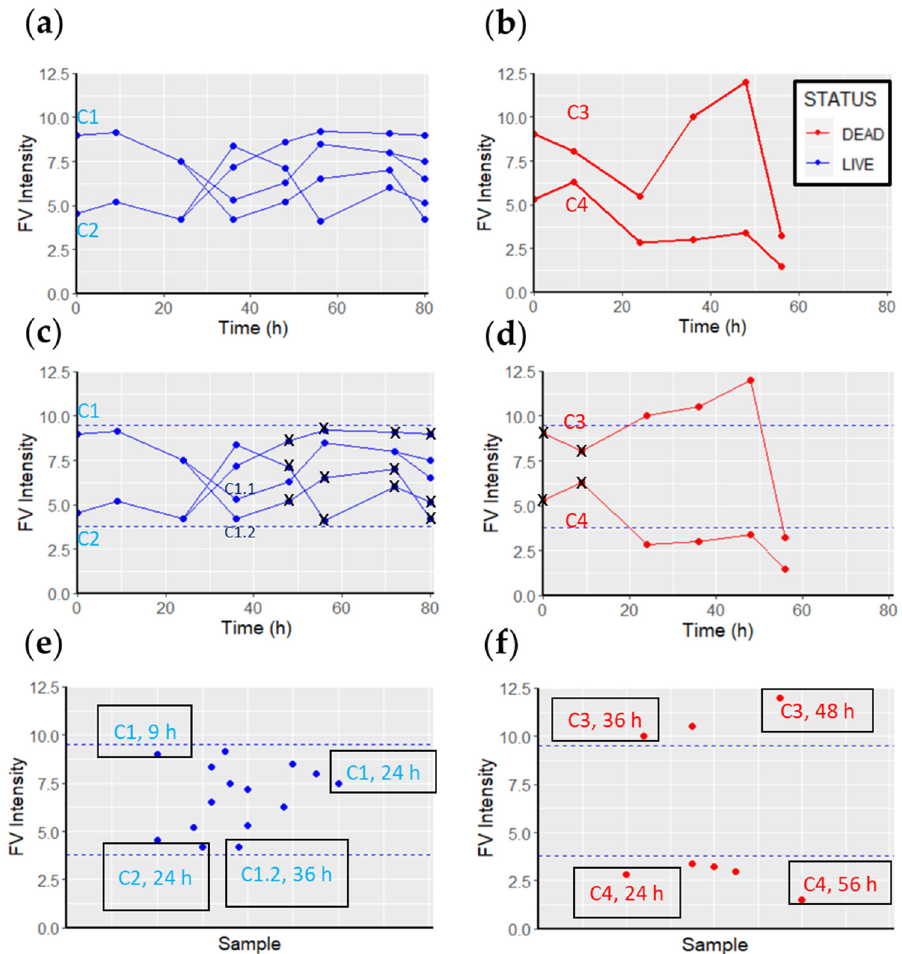
Figure 3. Correlation between FV fluorescence intensity, and cell viability or death. ( a ) FV intensity values measured in viable cells. ( b ) FV intensity values measured in dead cells. ( c ) Cell C1 replicated at t = 36 h, and its daughter cell, C1.1, at 80 h. The FV intensity values of the C1 cell for up to 36 h were recorded as viable FV intensity values. Similarly, all FV intensity values of the C1.1 cell up to 80 h were accounted for as viable FV intensities. The C1.2 cell did not replicate, so its FV intensity values were discarded (black crosses). Cell C2 replicated at t = 36 h. After this replication, none of the daughter cells replicated. Therefore, all FV intensity values up to 36 h are accounted for as viable FV intensity values, and the rest are discarded (black crosses). All viable FV intensities are considered to form the viable FV intensity range (within the dashed blue lines) (15 values in this example). ( d ) Both cells (C3 and C4) were lysed between the 56 and 72 h measurements. Therefore, the meas ‐ urements at t = 0 h and t = 9 h are discarded (black crosses), as they are not within the 48 h span. ( e ) All viable intensities of FV recorded during the 80 h monitoring period constitute the “live cell sam ‐ ple” (15 values in the example). ( f ) All intensities of FV recorded during the 80 h monitoring period that are associated with dead cells constitute the “dead cell sample”.